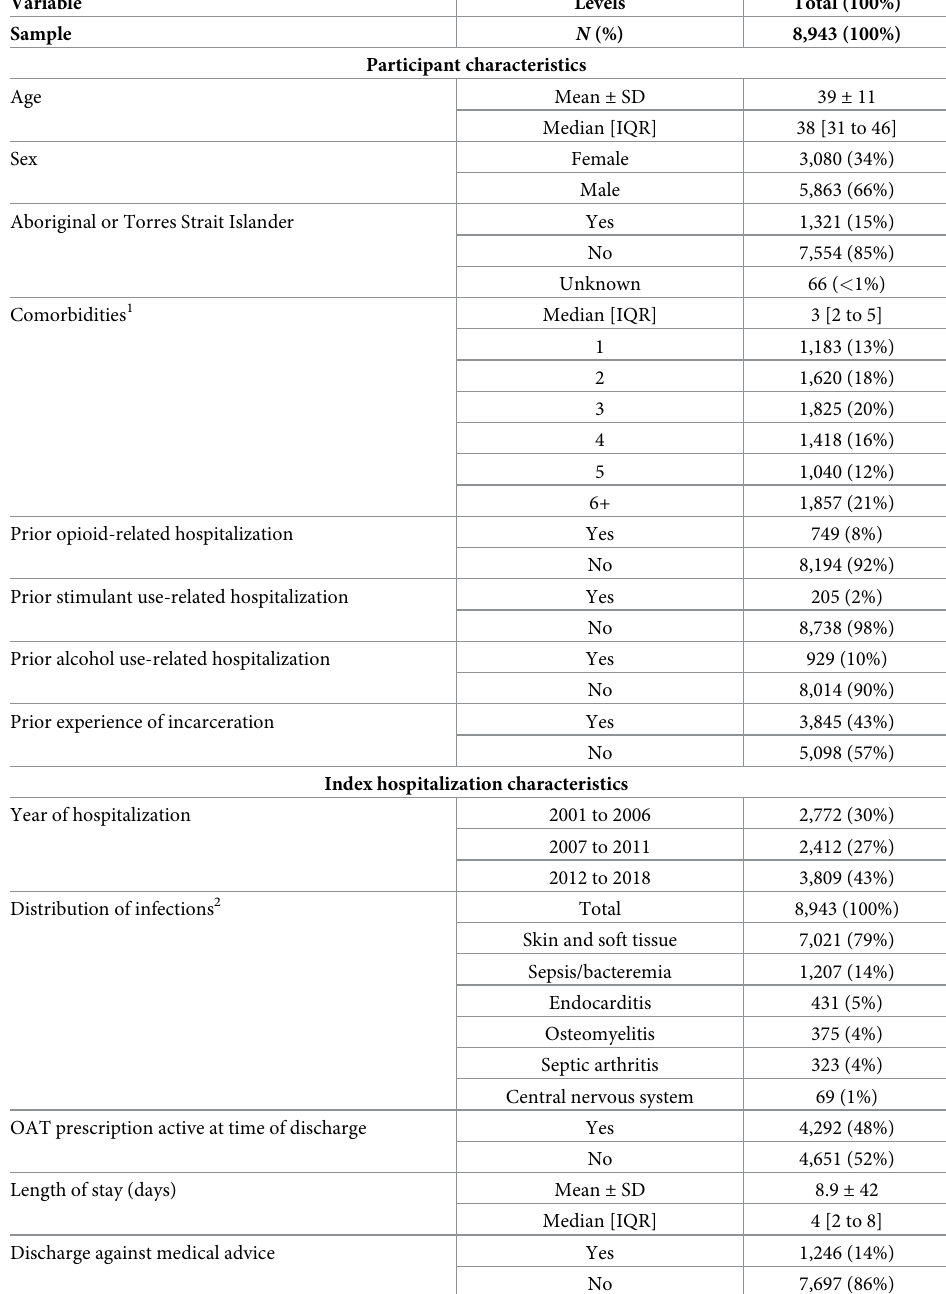
Table 1. Descriptive characteristics of the